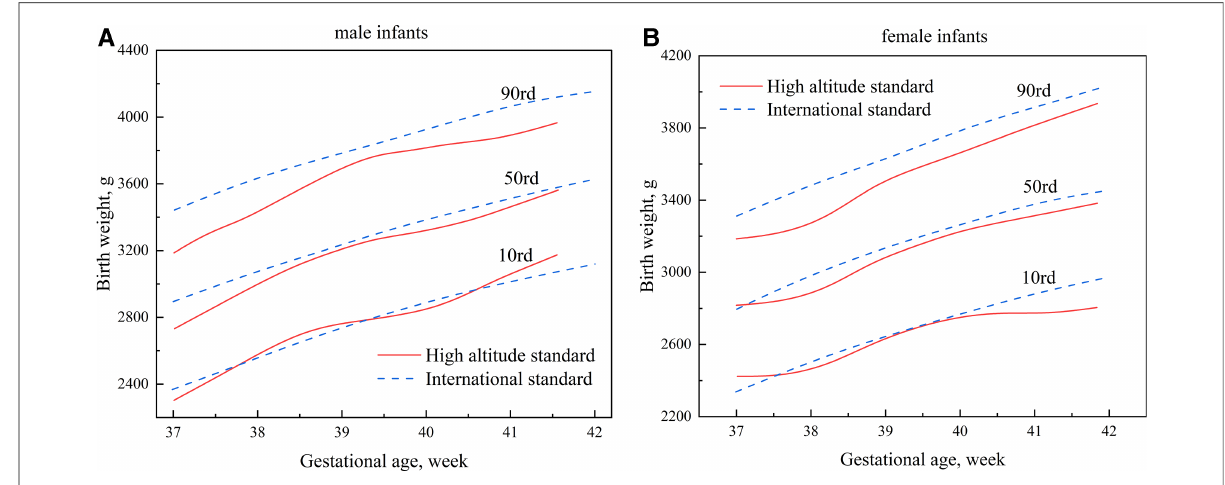
FIGURE 3 Comparisons of percentile curves of the high-altitude and international standards for neonatal birth weight ( A ): male infants; ( B ): female